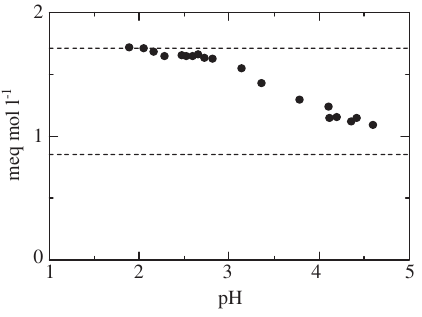
Figure 1 Effects of pH on the titration volume (colloidal titration curve) in colloidal titration of